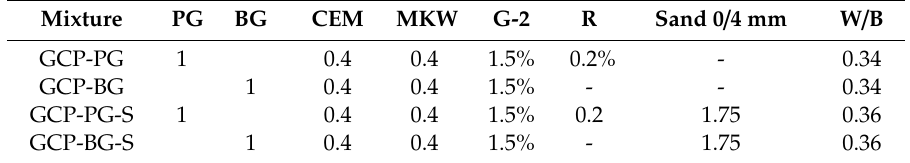
Table 2. Mixture composition of prepared ternary system binder paste and ternary system binder